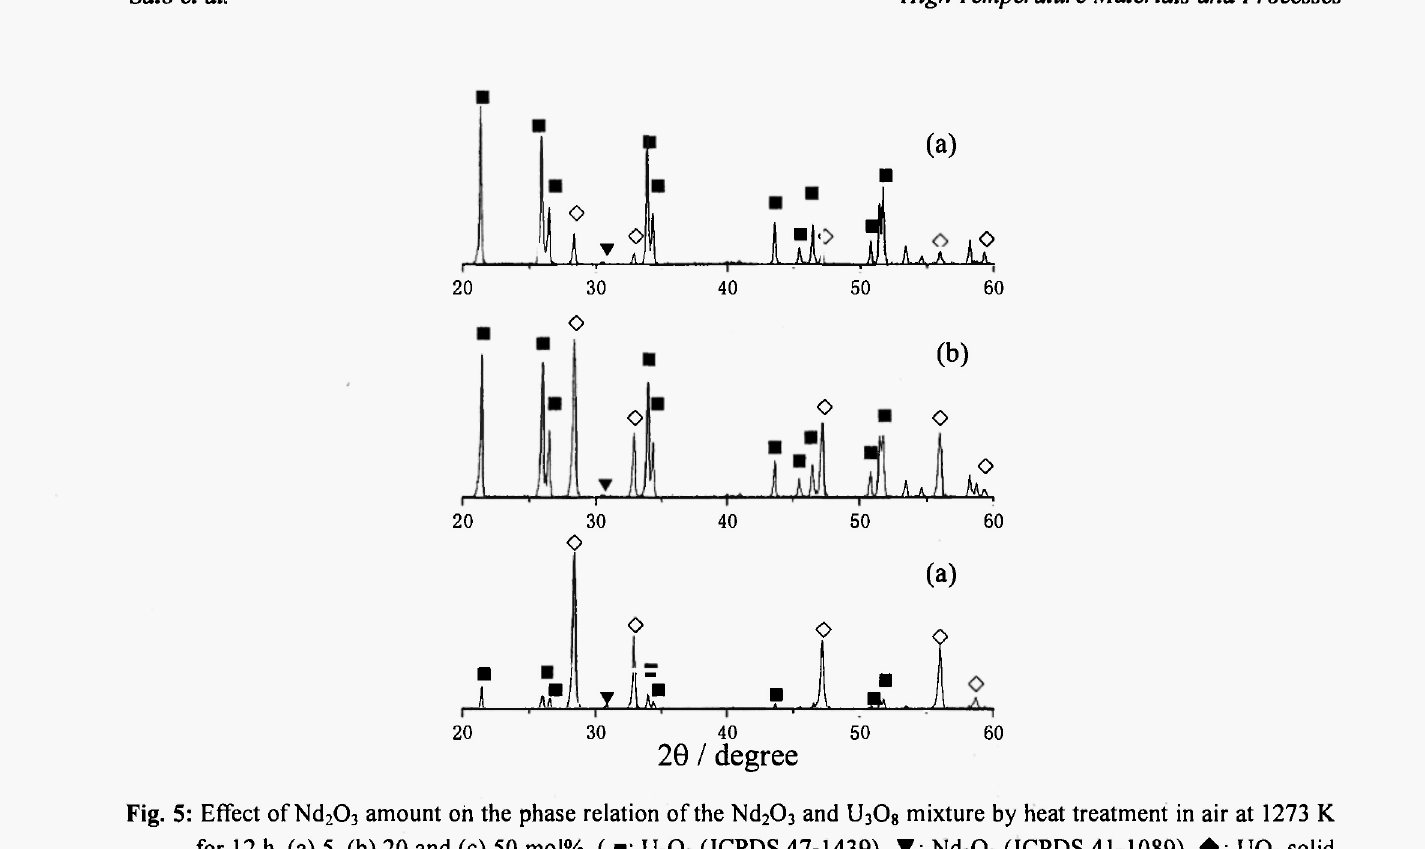
Fig. 5: Effect of Nd 2 0 3 amount oh the phase relation of the Nd 2 0 3 and U 3 0 8 mixture by heat treatment in air at 1273 Κ for 12 h. (a) 5, (b) 20 and (c) 50 mol%. ( •: U 3 0 8 (JCPDS 47-1439), • : Nd 2 0 3 (JCPDS 41-1089), •: